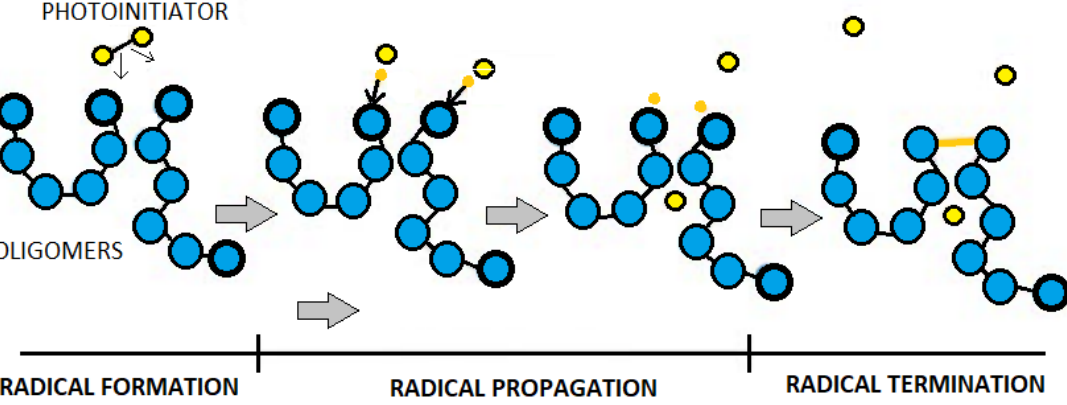
Figure 3. Scheme of photopolymerization of the stereolithography (SLA) resin.